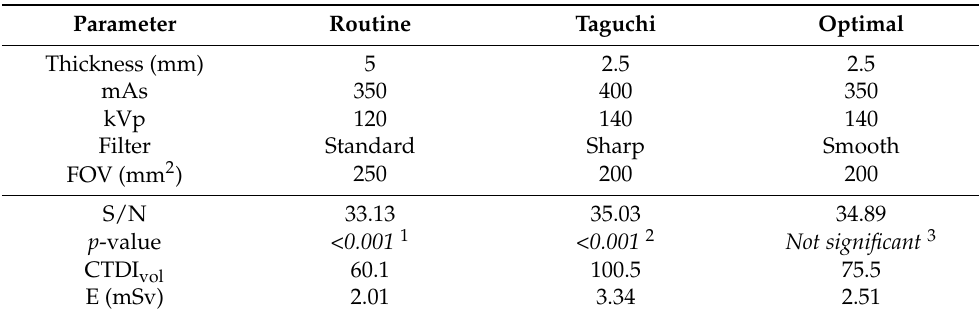
Table 5. Comparisons among the routine examination, the Taguchi experiment, and the optimal experiment in 128-slice brain CT examinations.